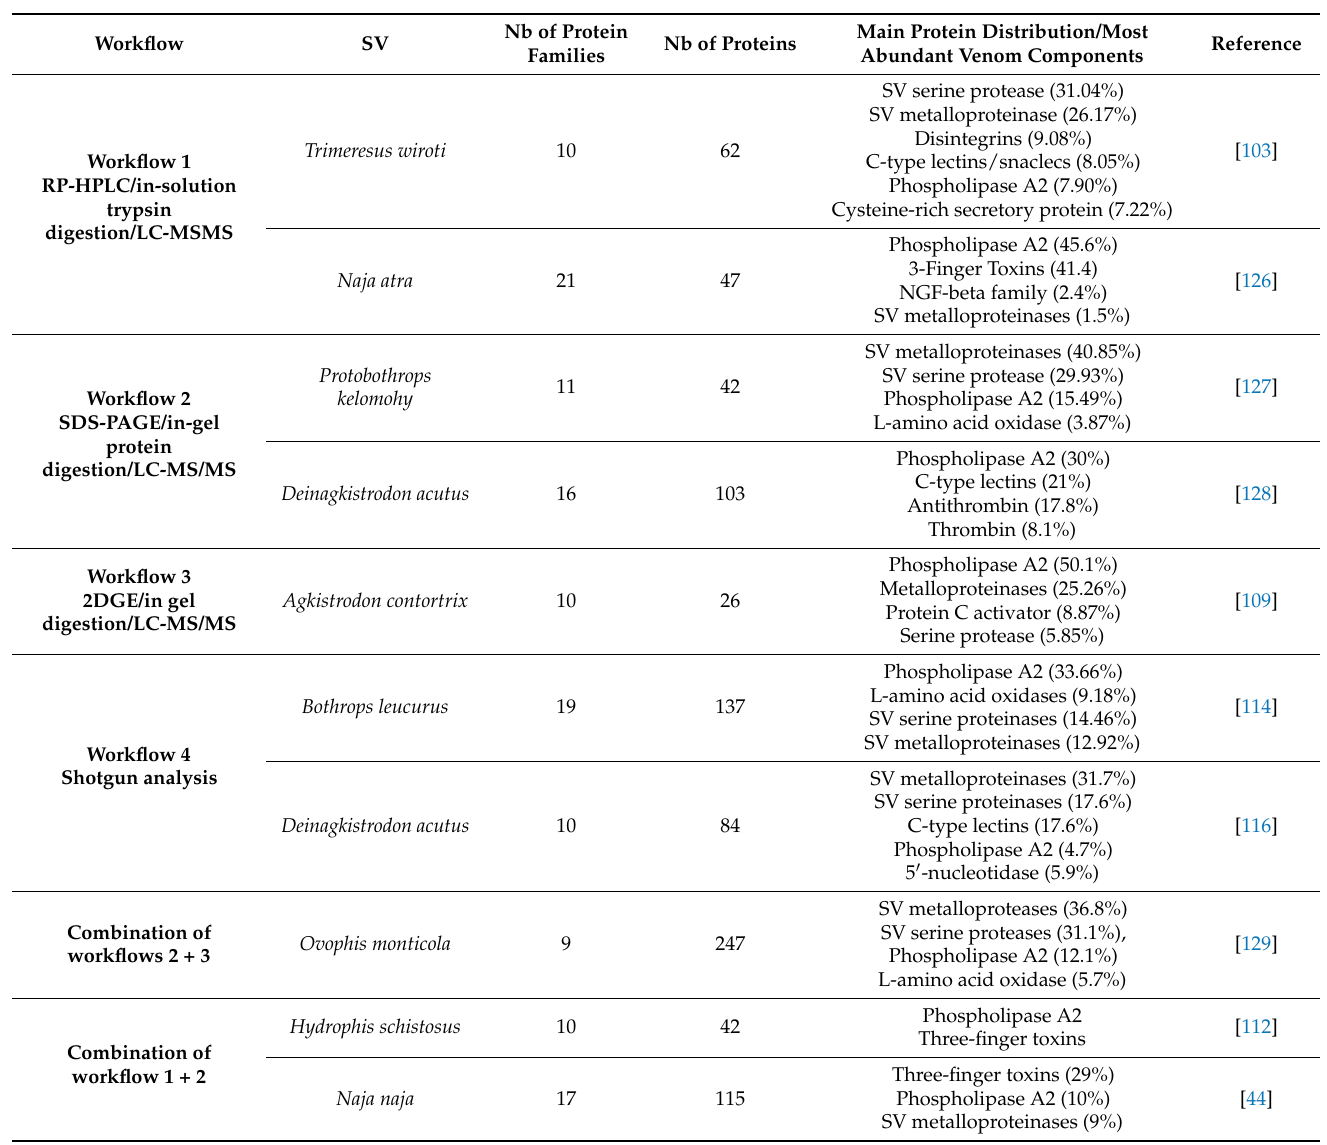
Table 3. Different workflows and strategies used in SV proteomic analysis, applications, and conse- quent findings. Da: